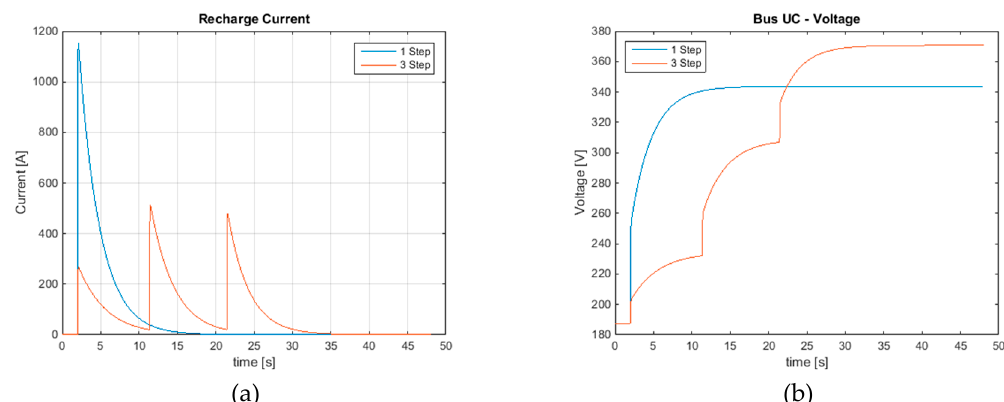
Figure 4. Comparison of 1-step and 3-step charge. ( a ) Charging current as a function of time, ( b ) bus supercapacitors voltage.